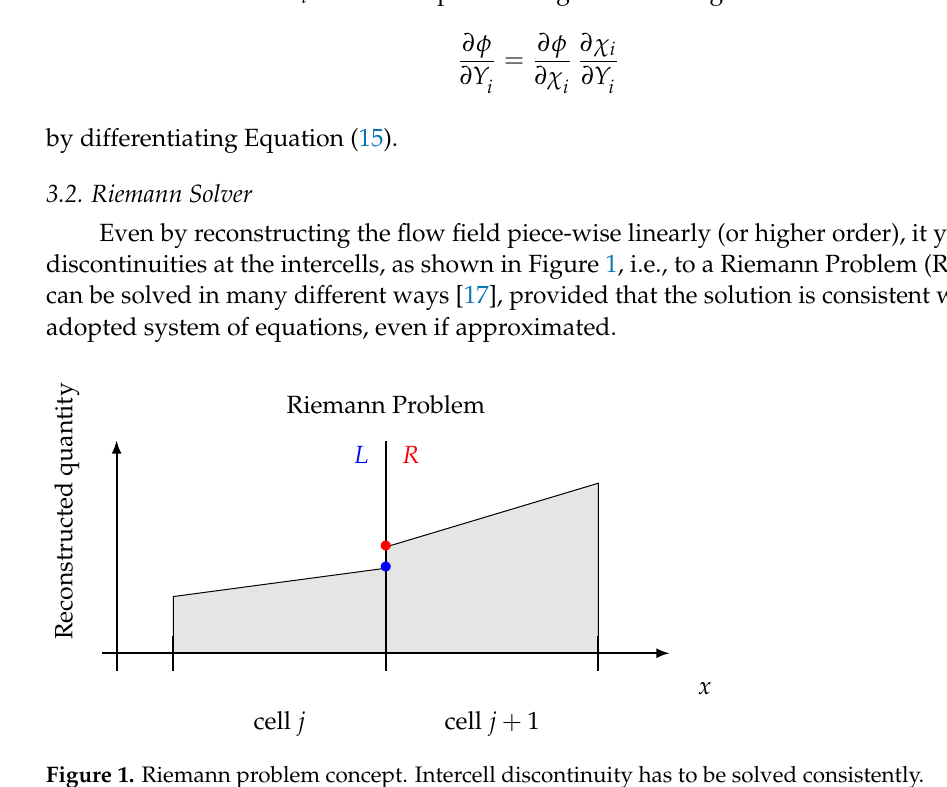
Figure 1. Riemann problem concept. Intercell discontinuity has to be solved